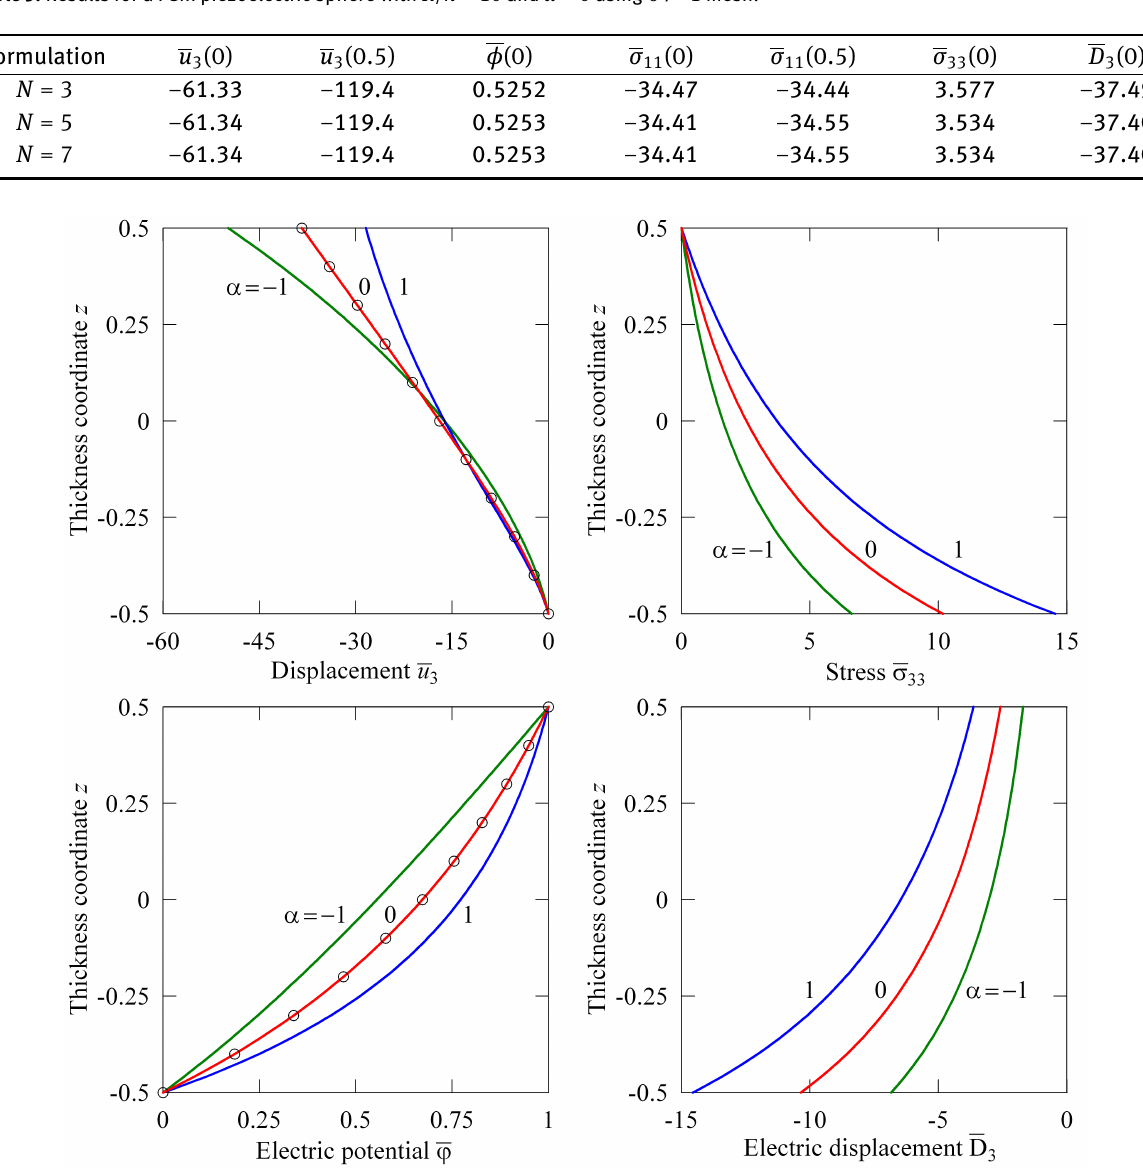
Figure 7: Through-thickness distributions of the displacement, stress, electric potential and electric displacement for a FGM piezoceramic sphere with R / h = 1.5 and N = 9 using 64 × 1 mesh; GeXSaS4 element (—) and Heyliger-Wu’s exact solution [48] for α = 0 ( ∘